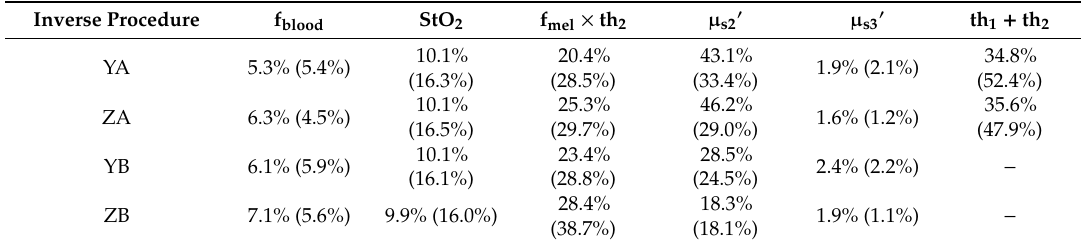
Table 2. Average absolute value and standard deviation (in parentheses) of errors in extracted tissue geometric and optical parameters using the six combinations of inverse fitting